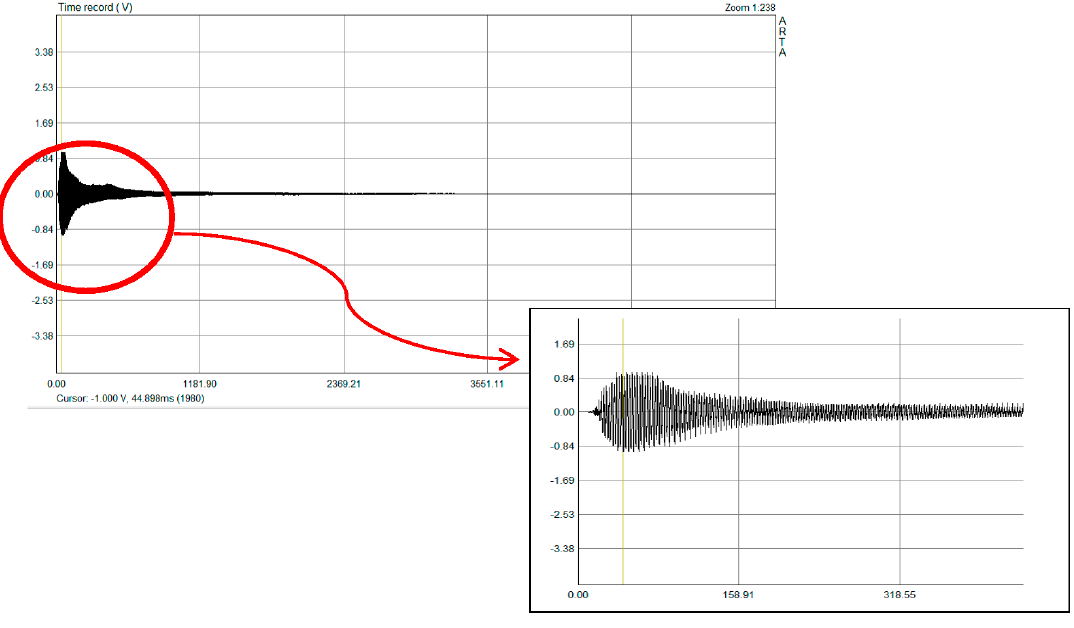
Figure 13. Mahava time record history.